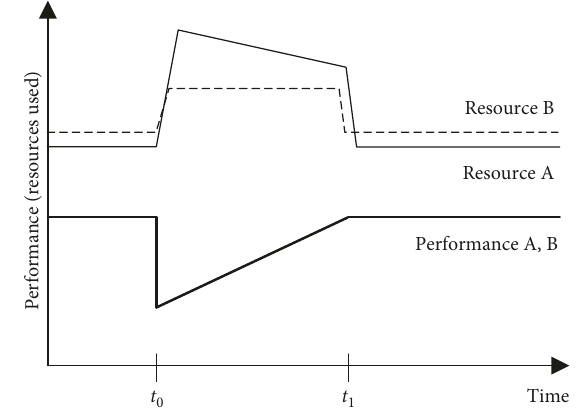
Figure 2: Examples of identical resilience triangle, with different use of resources A and